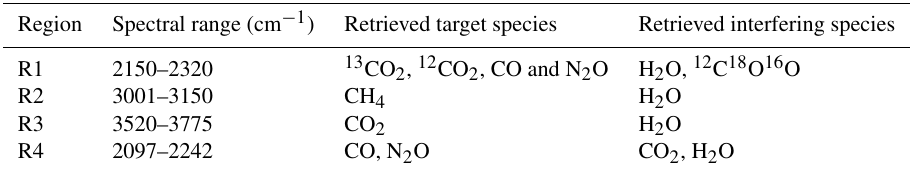
Table A1. MALT retrieval spectral regions and retrieved species within each